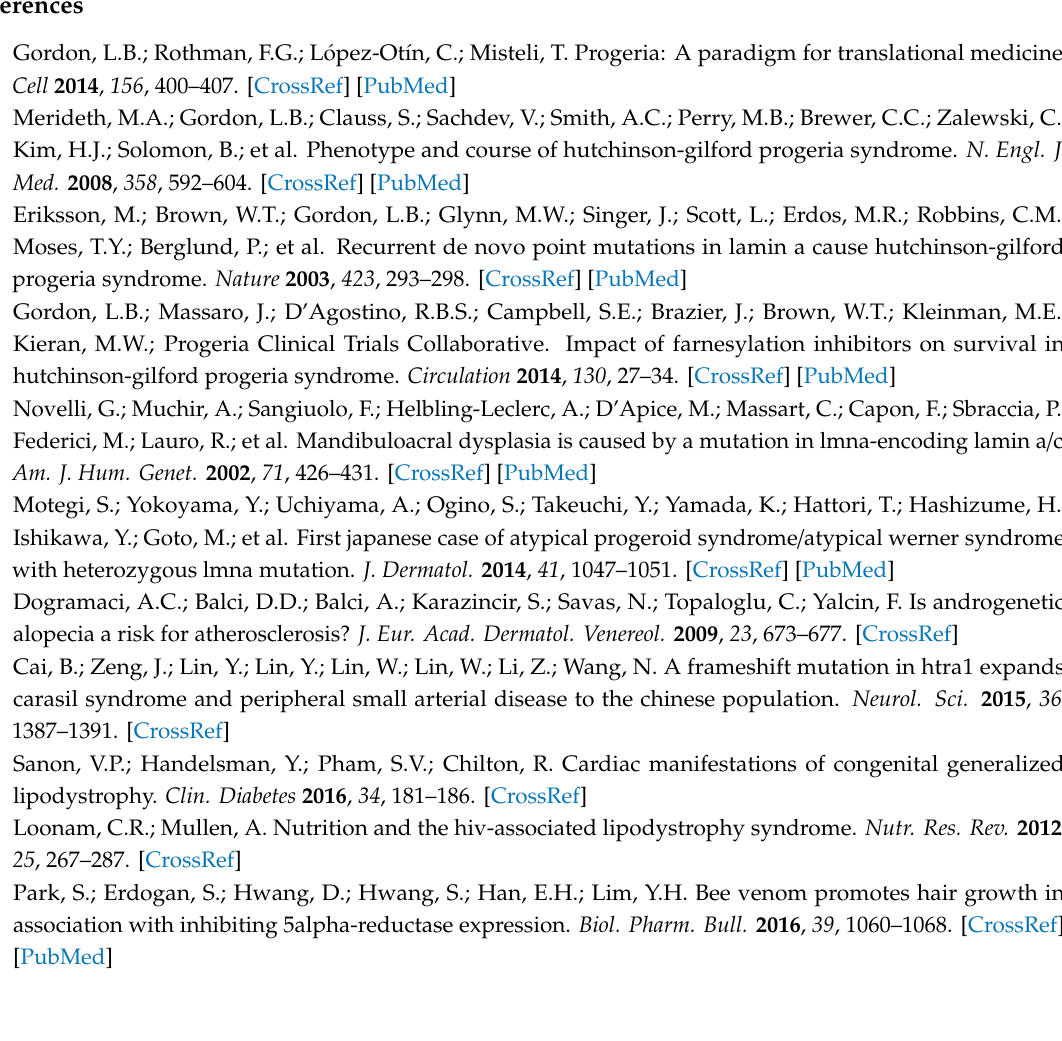
Figure S1: Real-time PCR analysis of the JAK and STAT gene families in normal and HGPS cells, Figure S2: Cytotoxicity and stability of Bar in a cell-based aging model, Figure S3: Bar treatment ameliorates HGPS nuclear morphology, Figure S4: Real-time PCR analysis of the 17 genes identified by text mining in normal and HGPS cells treated with Bar for 1 month, Table S1: Dataset File 1: Excel file of the list of genes associated with vascular disease, arthritis, lipodystrophy and alopecia derived from the text mining analysis, Table S2: Di ff erential regulation of the 17 genes altered in all four conditions, Table S3: Dataset File 2: Excel file of the identified list of transcription factors that regulate the 17 genes derived from text mining, Table S4: Primers used for the real-time quantitative PCR analysis of the 17 genes identified by text